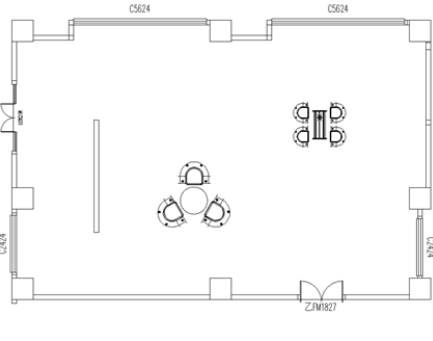
Figure 1. Layout of Room A